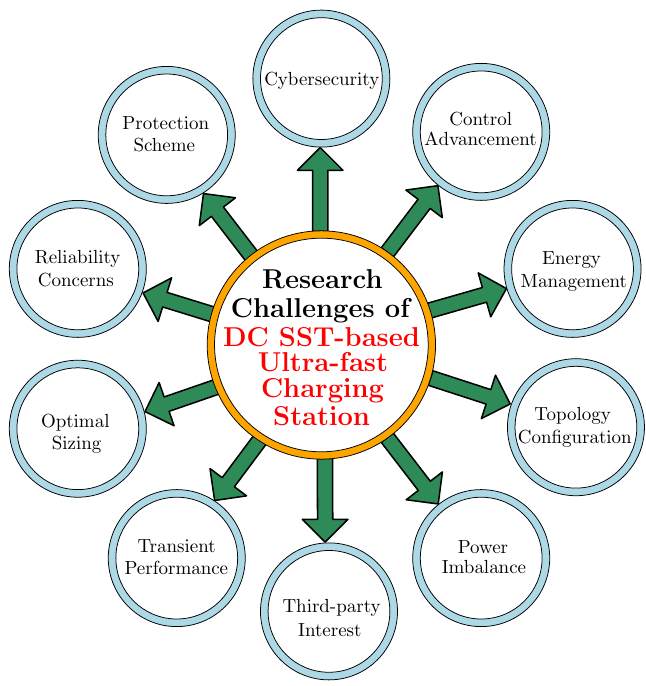
Figure 12. Research challenges in the DC SST-based ultra-fast charging